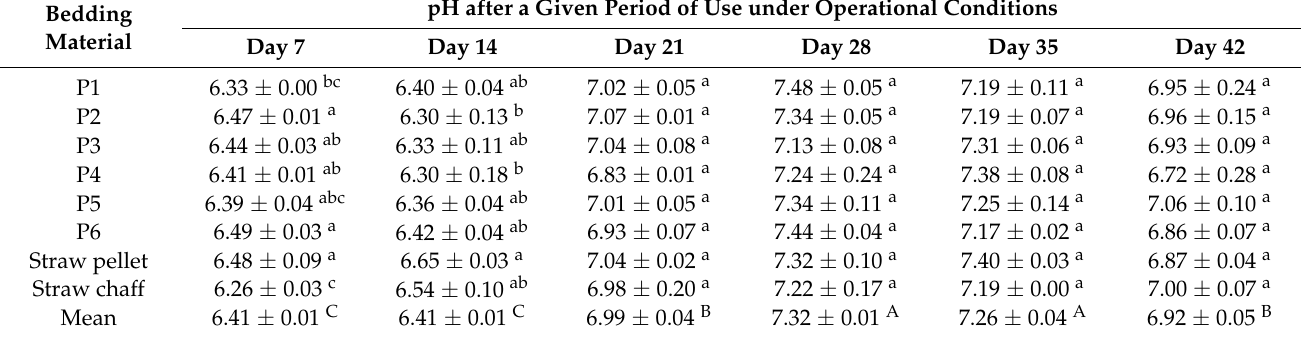
Table 3. Changes in the pH of bedding materials during their exploitation—1st experimental cycle.